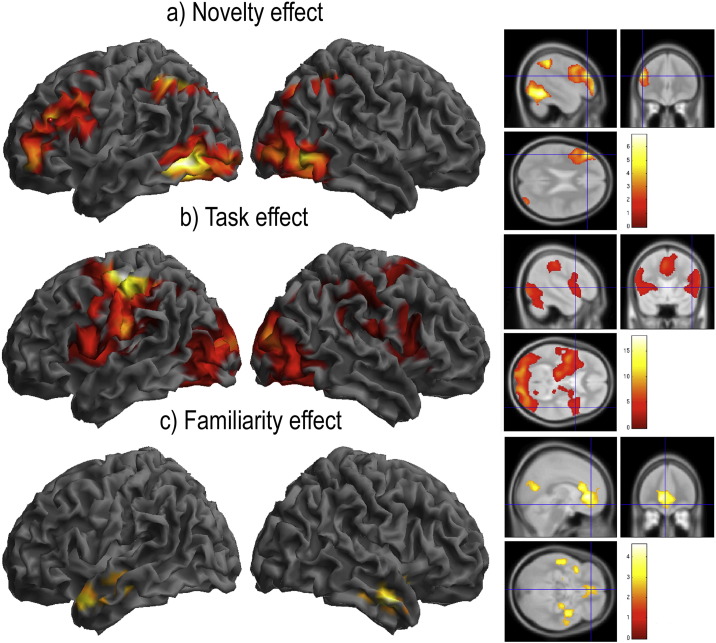
Supplemental whole-brain analyses of data from study 1 (all rendered at p < 0.05 FWE cluster corrected for the whole brain volume). Voxelwise analysis using a novelty contrast during learning by instruction (Stages 1–6 weighted as 3 2 1 − 1 − 2 − 3) rendered significant effects across a set of brain regions including the left IFS and the IPC bilaterally (S2a). A Task contrast (Stages 1–6 all weighted as 1) rendered activation across a set of brain regions including the AIFO and ACC (S2b). The negative effect of Novelty rendered significant voxels within brain regions that approximately conform to the default mode network (Buckner et al., 2008) (S2c). There were no significant voxels within the striatum for any of the above contrasts even at the uncorrected threshold of p < 0.05 one-tailed.